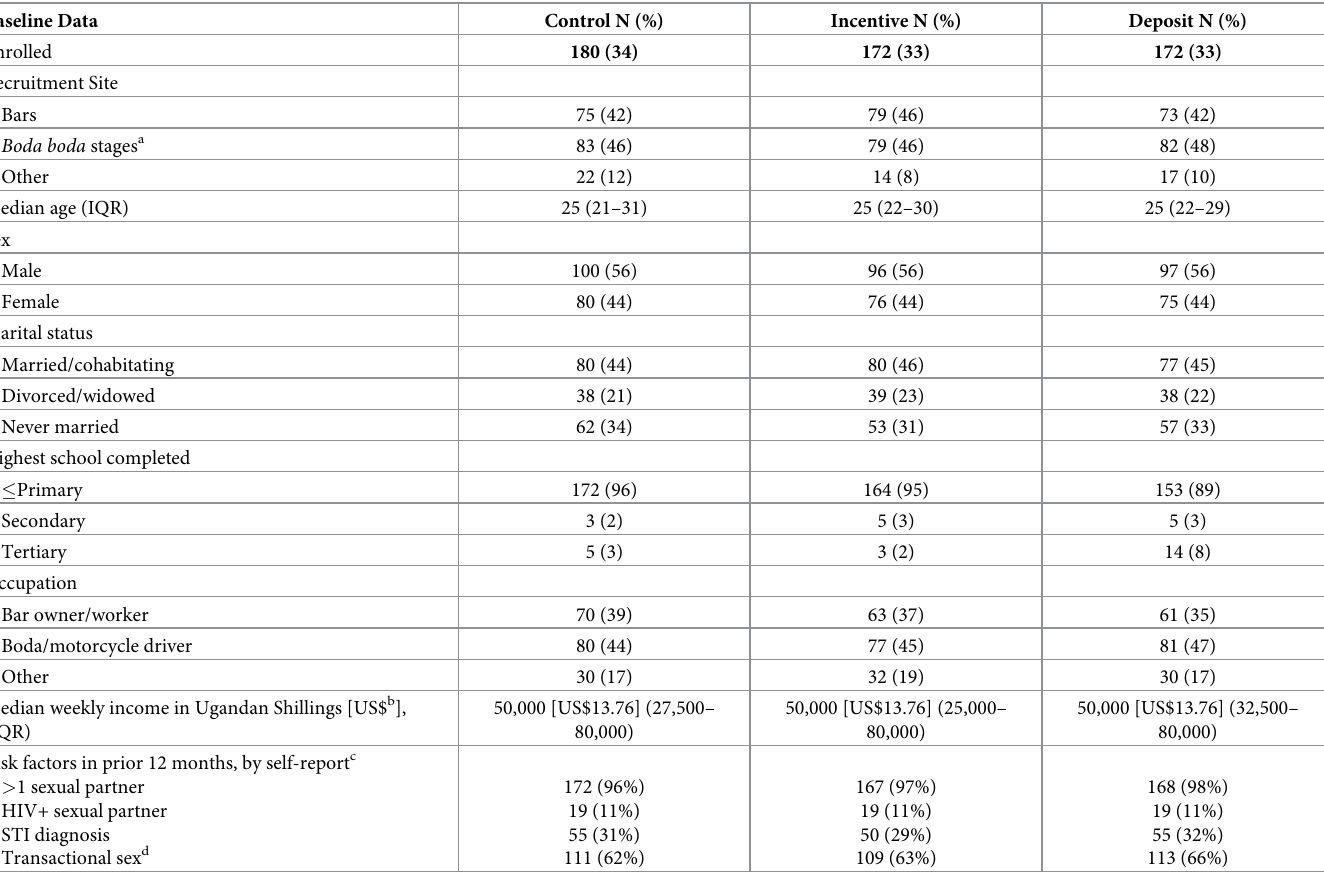
Table 1. Baseline characteristics of participants by study group in a randomized trial of financial incentives and deposit contracts to promote HIV